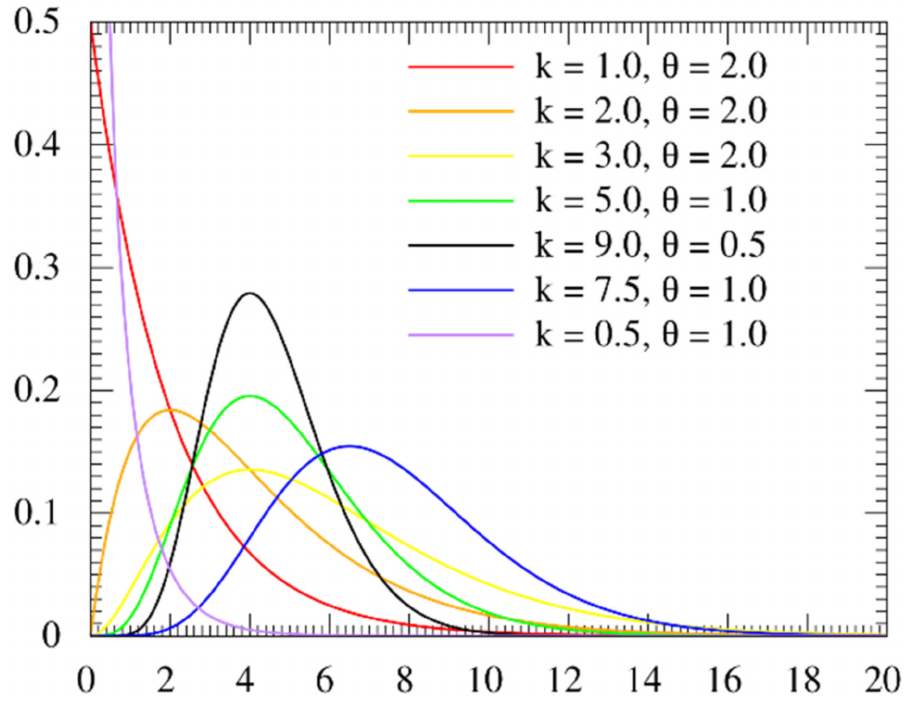
Figure 2. Gamma Probability Density